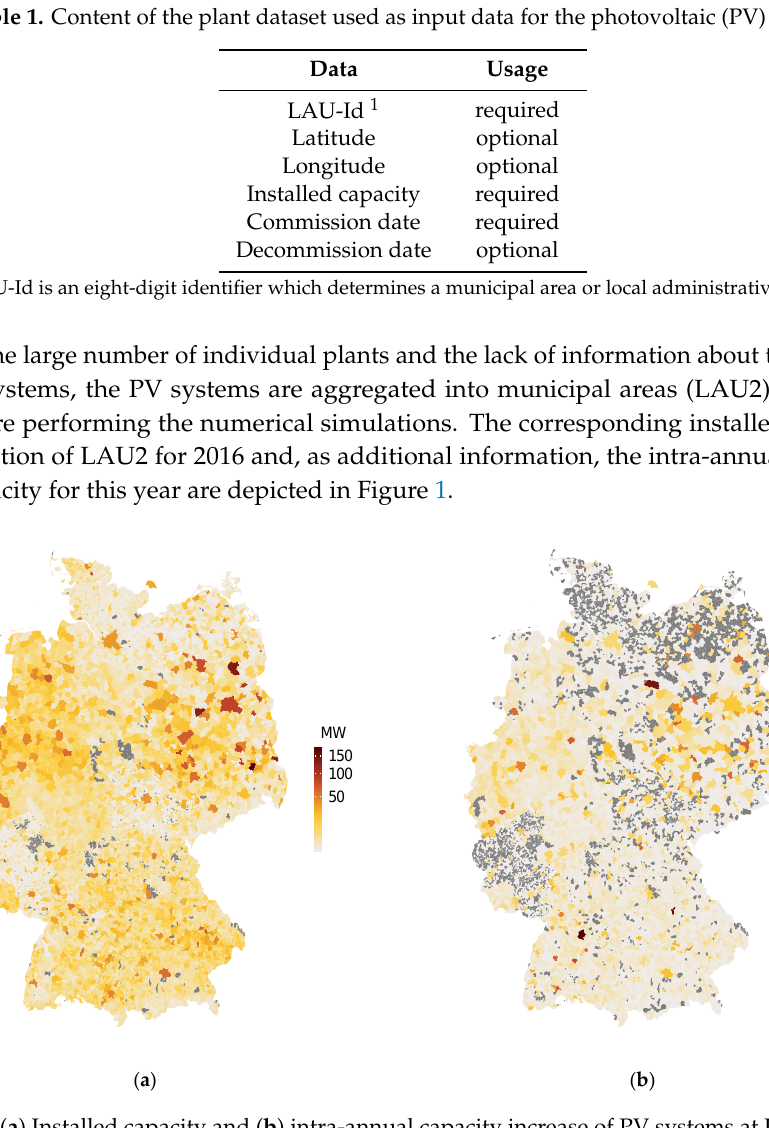
Figure 1. ( a ) Installed capacity and ( b ) intra-annual capacity increase of PV systems at LAU2 level in Germany for 2016. In the dark grey areas no PV systems are ( a ) installed or ( b ) have been added during this year.